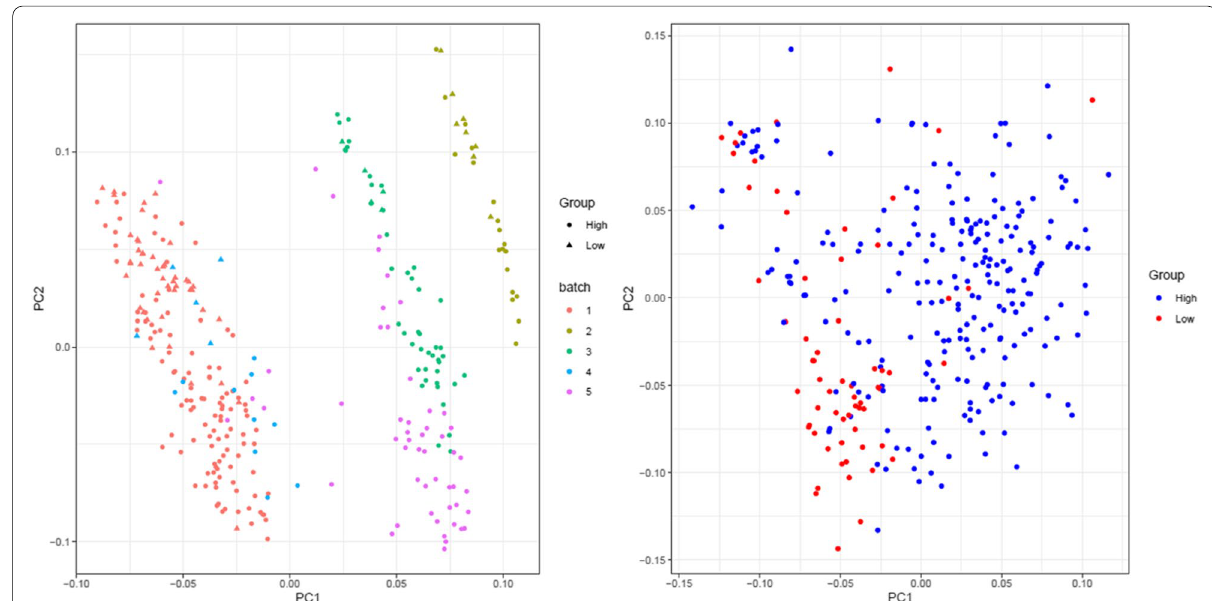
Fig. 1 PCA scatter plot based on gene expression profiles in 301 samples from 5 datasets. Left: Merged datasets before batch effect correction; datasets are specified with different colors. LGG and HGG samples are shown with circle and triangle symbols, respectively. Right: Merged datasets after batch effect correction; blue and red dots are shown HGG and LGG samples, respectively